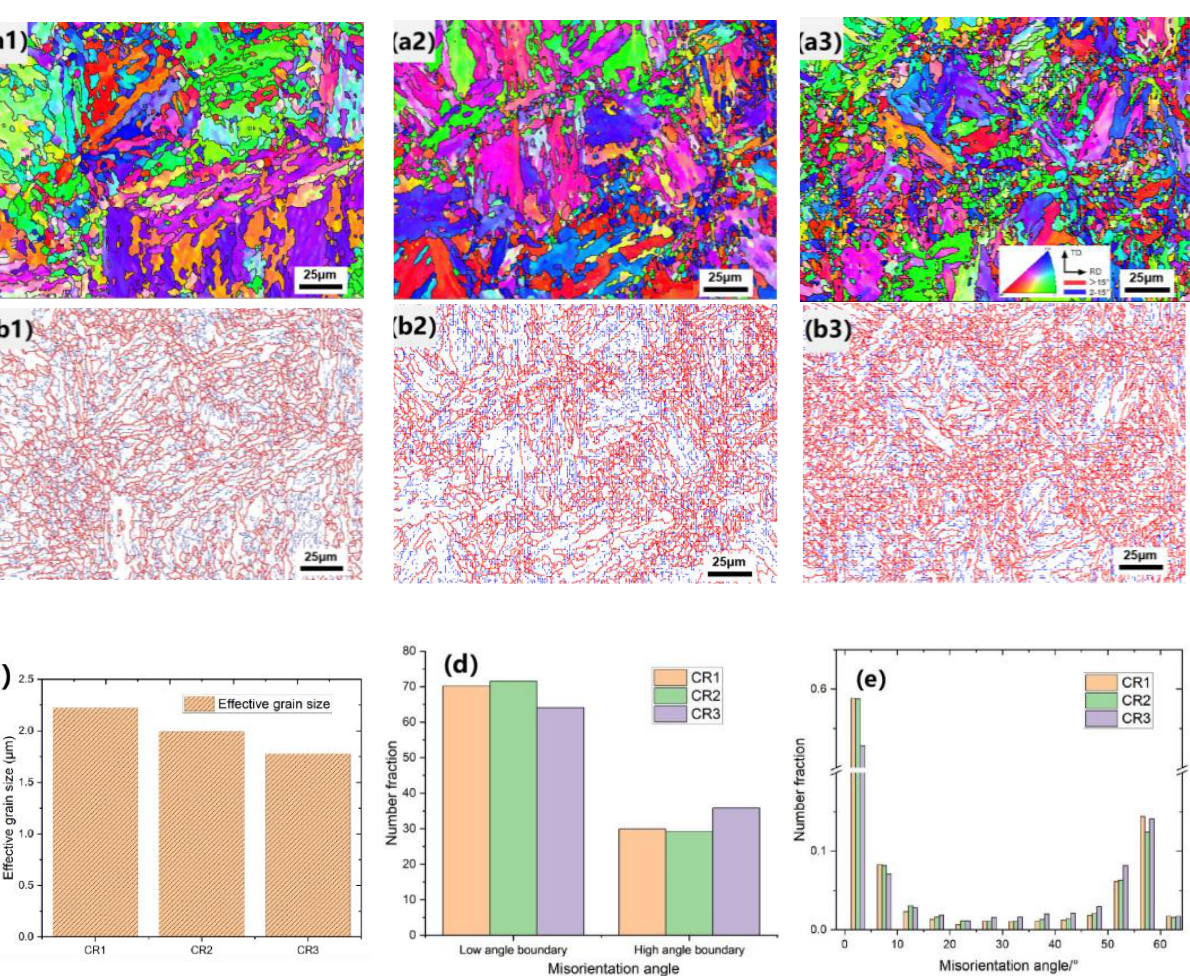
Figure 4. EBSD results of ( a1 – a3 ) IPF maps; ( b1 – b3 ) grain boundary misorientation maps; ( c ) cal- culated effective grain size graph; ( d ) statistics of high- and low-angle boundaries and ( e ) distribu- tion of grain boundaries.